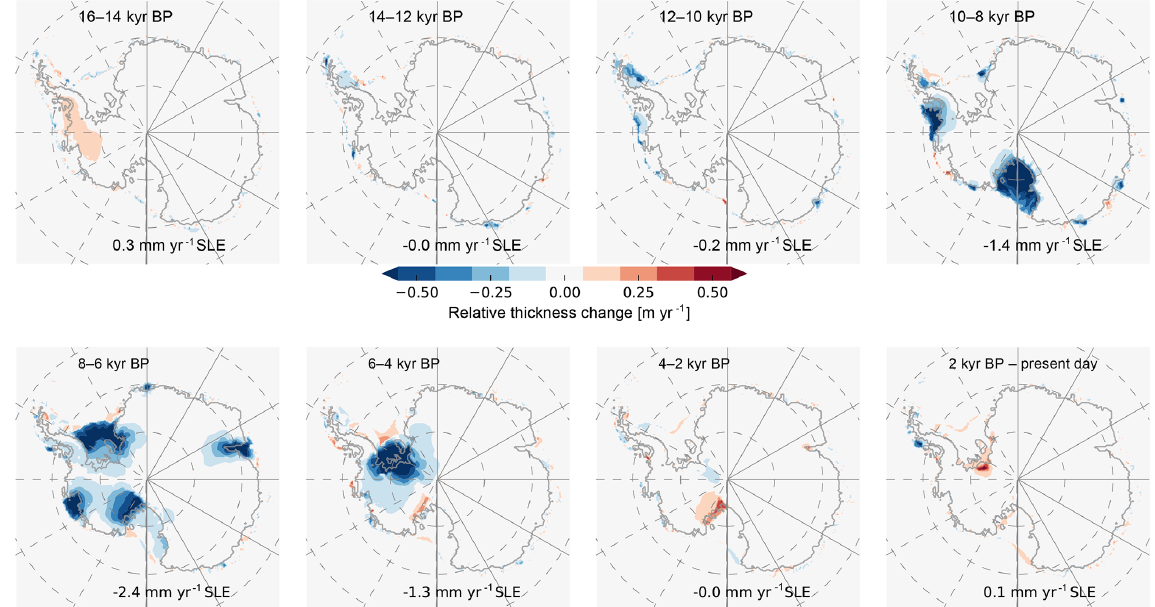
Figure 16. Snapshots of relative ice thickness change rates every 2kyr over last 16kyr in best-fit simulation, analogous to Fig. 4 in Golledge et al. (2014). Deglaciation starts in the Ross and Amundsen sector after 10kyrBP, with a mean change rate of − 1 . 4mmyr − 1 SLE, followed by the Amery and Weddell Sea sector after 8kyrBP, with mean change rates of up to − 2 . 4mmyr − 1 SLE. In the late Holocene period since 4kyrBP, the best-fit simulation shows some thickening on the Siple Coast and in the Bungenstock Ice Rise, corresponding to about + 0 . 1mmyr − 1